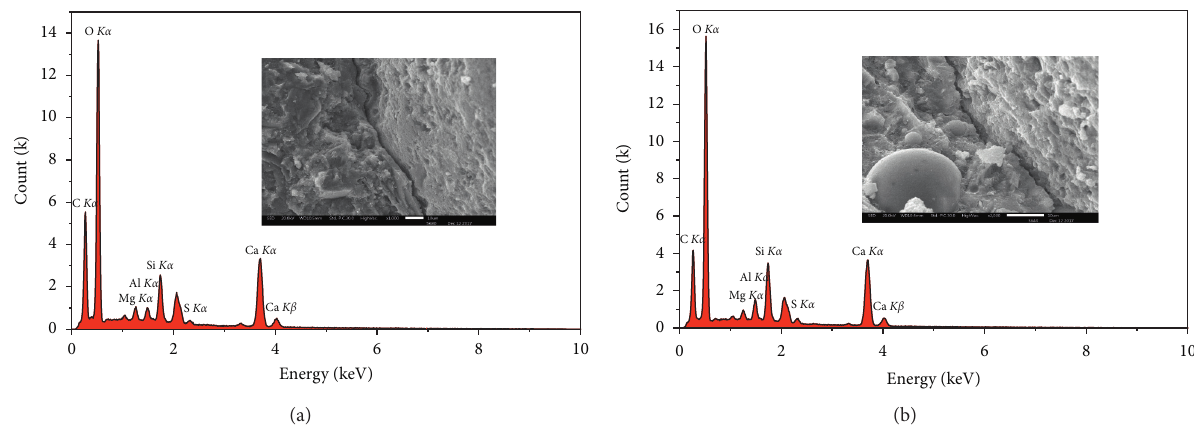
Figure 8: EDS results of the interface of mortar samples with and without mineral admixture at 7d: (a) CCS and (b) CFSCS. CCS: coral mortar; CFSCS: coral mortar with 15% fly ash and 15% slag.